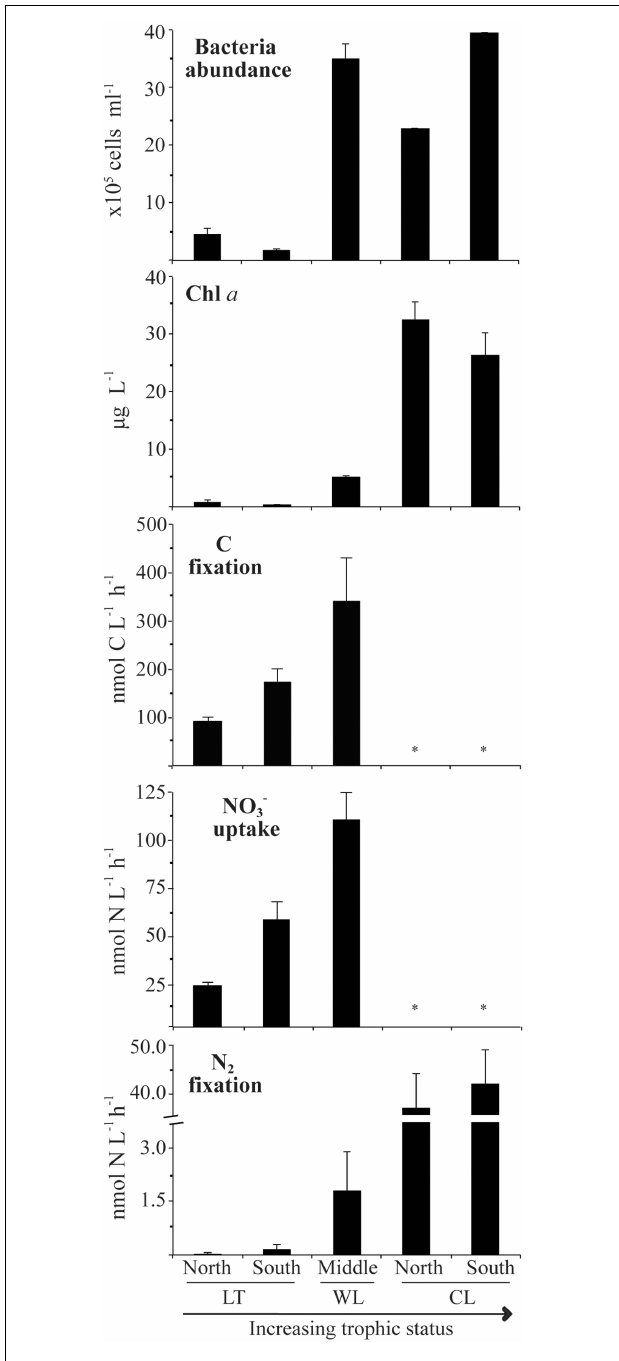
FIGURE 2 |Variability of biological parameters during the period studied from 2009 to 2010 (LT: LakeTahoe;WL:Walker Lake; CL: Clear Lake). Measurements not determined denoted by *.Water samples were taken from 0.5m below the surface. Data shown as arithmetic mean ± SE ( N =